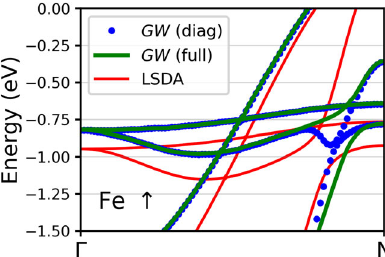
Fig. 3 Role of off-diagonal self-energy matrix elements in bcc Fe. Enlarged view of the iron spin-up band structure obtained from LSDA and two GW approaches: one [ GW (full)] includes off-diagonal elements of the self-energy, the other [ GW (diag)] does not. For clarity, lifetime broadening is suppressed. GW (diag) leads to an unphysical band dispersion close to the N point. Its correction requires the treatment of the self-energy as a full matrix [ GW